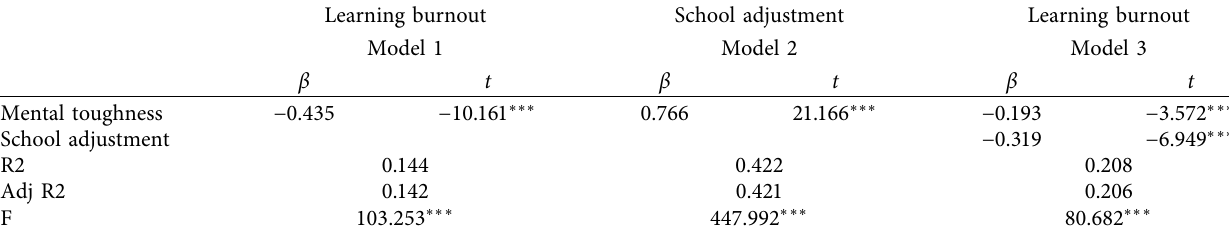
Table 10: Mediation analysis table.